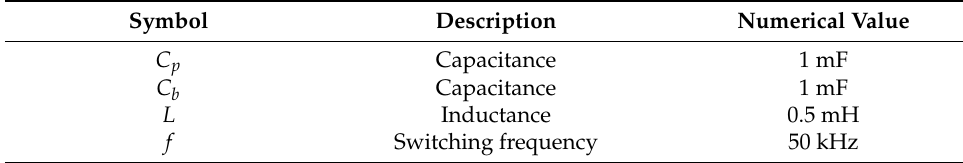
Table 2. Boost converter parameters.